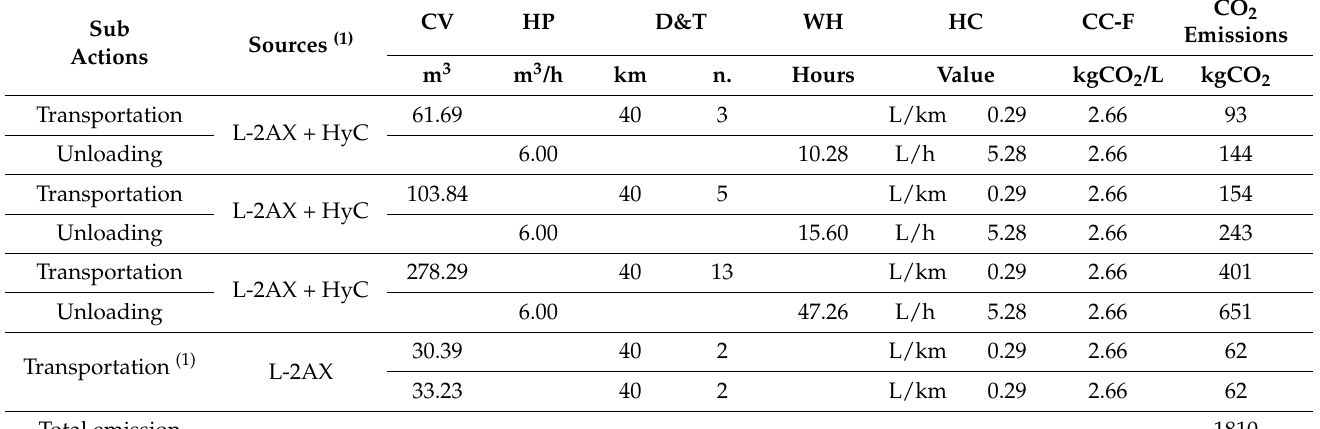
Table 8. Emissions during transportation from forest to sawmill of poles, shoots and chips (for this action the chestnut fresh density adopted is 1010 kg/m 3 ) [40]. Legend: (1) HyC: Hydraulic Clamp; L-2AX: Lorry (2 axles); CV: Chestnut Volume; HP: Hourly Productivity; HC: Hourly Consumption; KC: Kilometer Consumption; CC-F: Conversion Coefficient of Fuel; T: Times; D: Distance; WH: Working